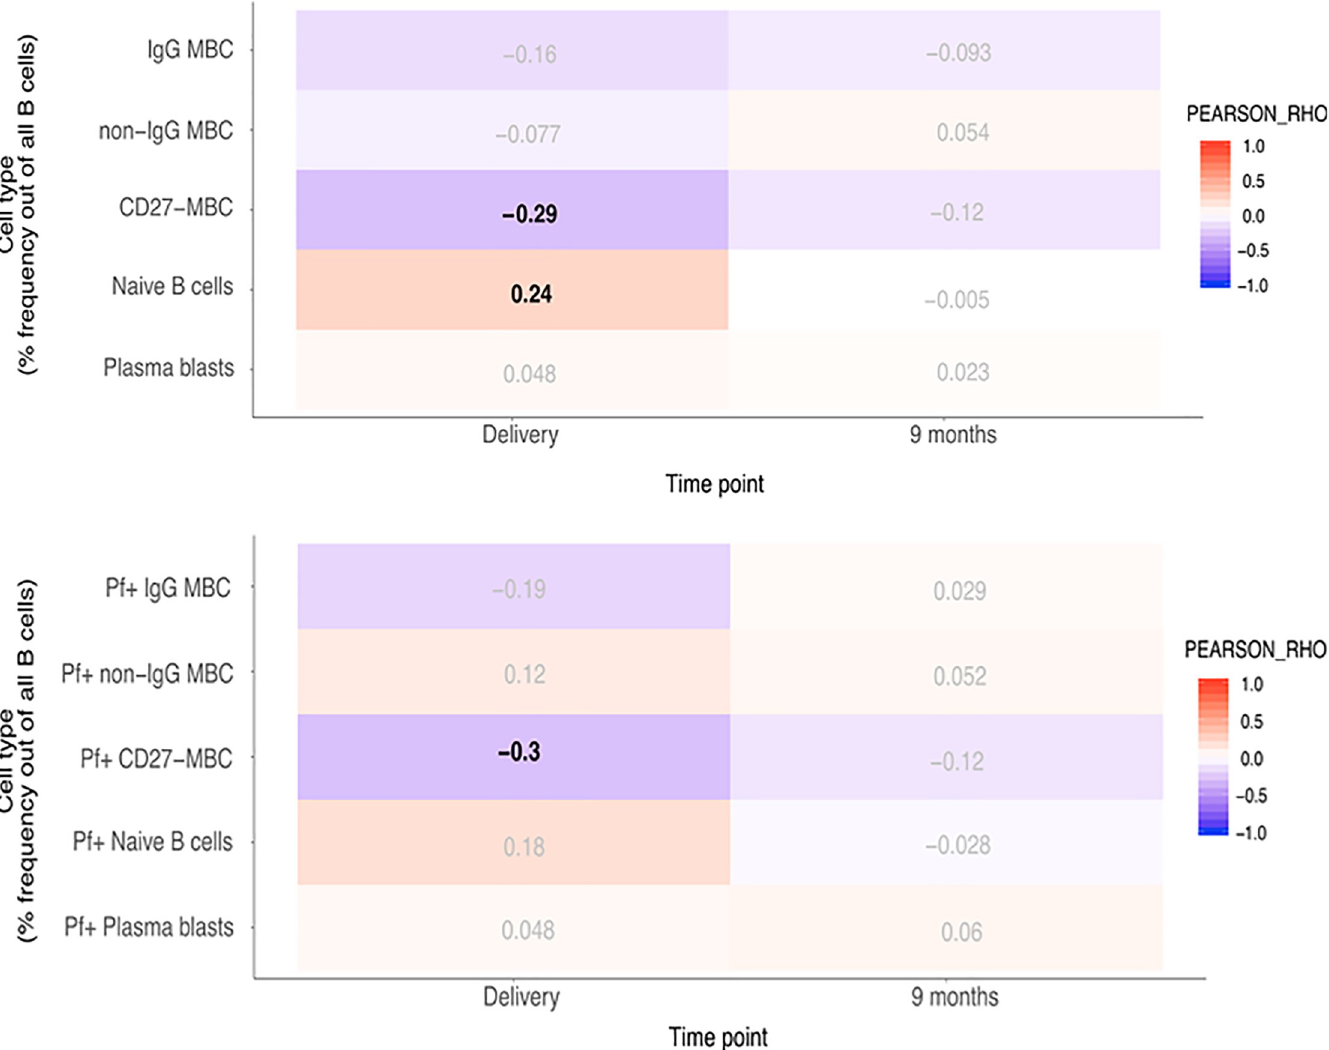
Fig 3. Correlation heatmap of BAFF concentration and given subsets of B cells in mothers. A. Pearson correlation with adjusted p-value for multiple testing using the Benjamini-Hochberg method. Pearson’ rho values with a false discovery rate (FDR) < 0.05 in bold. B. Correlation heatmap of BAFF concentration and Pf + proportions of given subsets of B cells in mothers. Pearson correlation with adjusted p-value for multiple testing using the Benjamini-Hochberg method. Pearson’ rho values with a false discovery rate (FDR) < 0.05 in